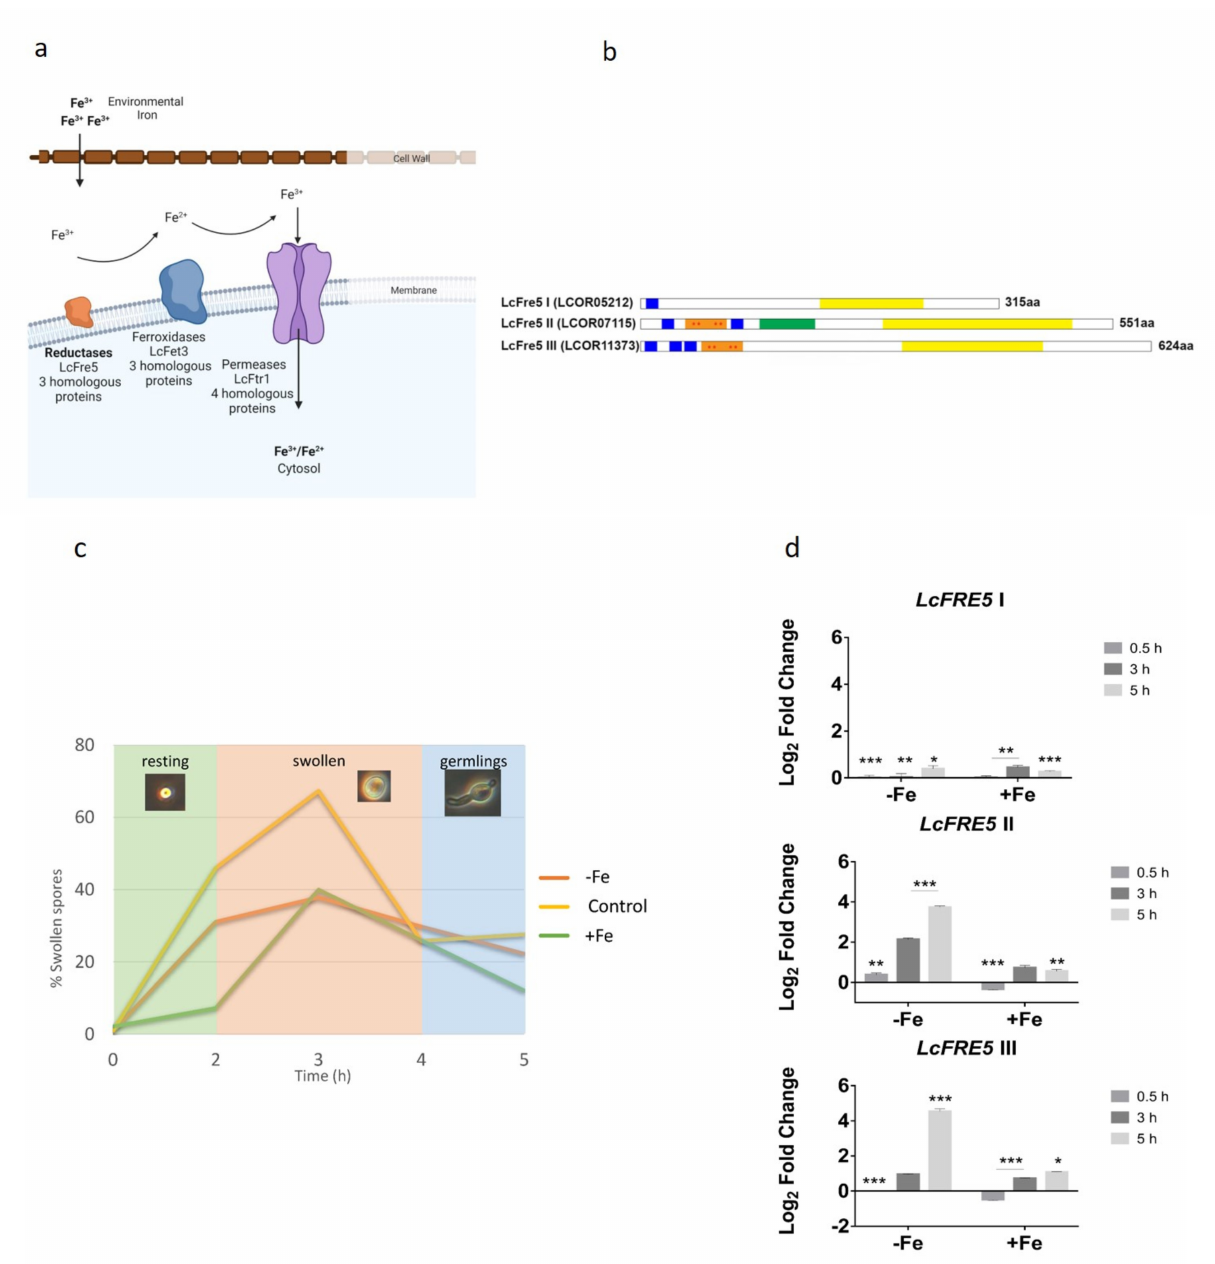
Figure 1. Simplified model of the reductive iron assimilation (RIA) pathway in L. corymbifera . ( a ) Putative proteins identified for the RIA in L. corymbifera . ( b ) Schematic representation— L. corymbifera transmembrane ferric reductases present typical domains: ferric reductase domain (orange box); FAD-binding domain (green box); and NAD binding domain (yellow box). Asterisks (red) indicate the conserved histidine residues (4 conserved residues) belonging to the bis-heme motif. Transmembrane region indicated by the blue boxes. The number of amino acids (aa) of each protein is indicated adjacent to the sequences. ( c ) Percentage germination of spores under different iron conditions over time; Control medium supplemented with 0.2 mM FeCl 3 ; −Fe (iron depletion) simulated using 0.2 mM BPS; +Fe simulated using 1.0 mM FeCl 3 . ( d ) Early expression profile (log 2 -fold change) relative to the control of the putatively encoding L. corymbifera ferric reductase ( LcFRE5 I-III) under iron starvation (0.20 BPS) and iron stress (1.0 mM FeCl 3 ). Asterisks indicate statistical significance determined by Student’s t -tests comparing treatment and control conditions (* p < 0.05; ** p < 0.01; *** p < 0.001). Data are means and standard error of three independent experiments. Illustrations created with BioRender.com (accessed on 25 January